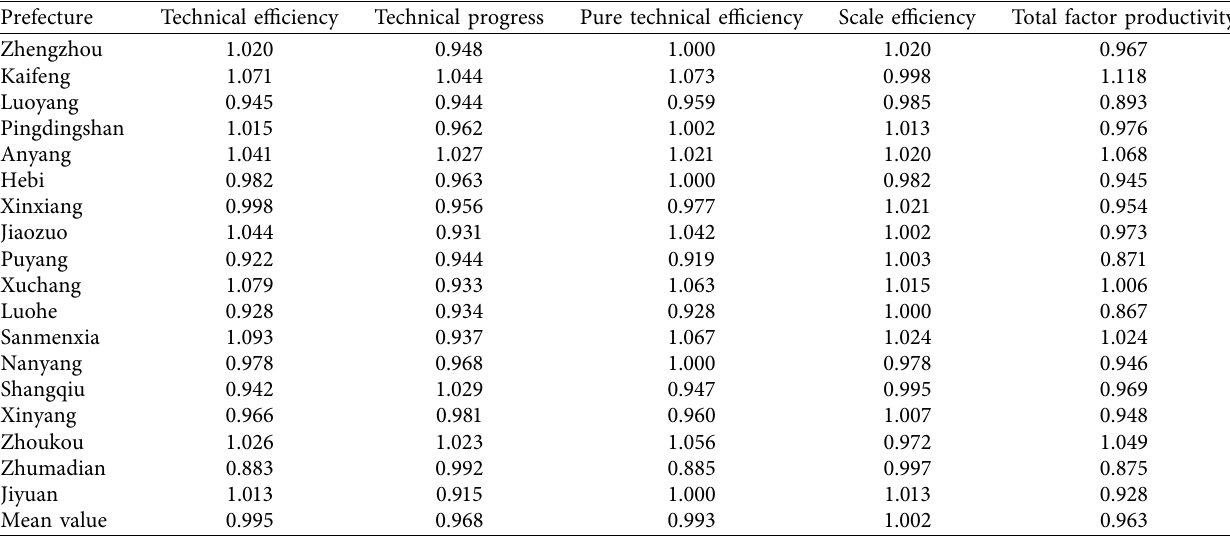
Table 5: Malmquist index of vegetable circulation in Henan Province.